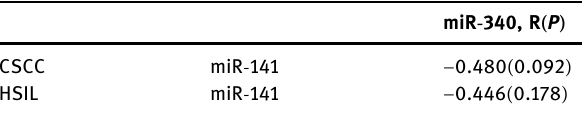
Table 5: Correlation of miR - 141/miR - 340 in CSCC and HSIL